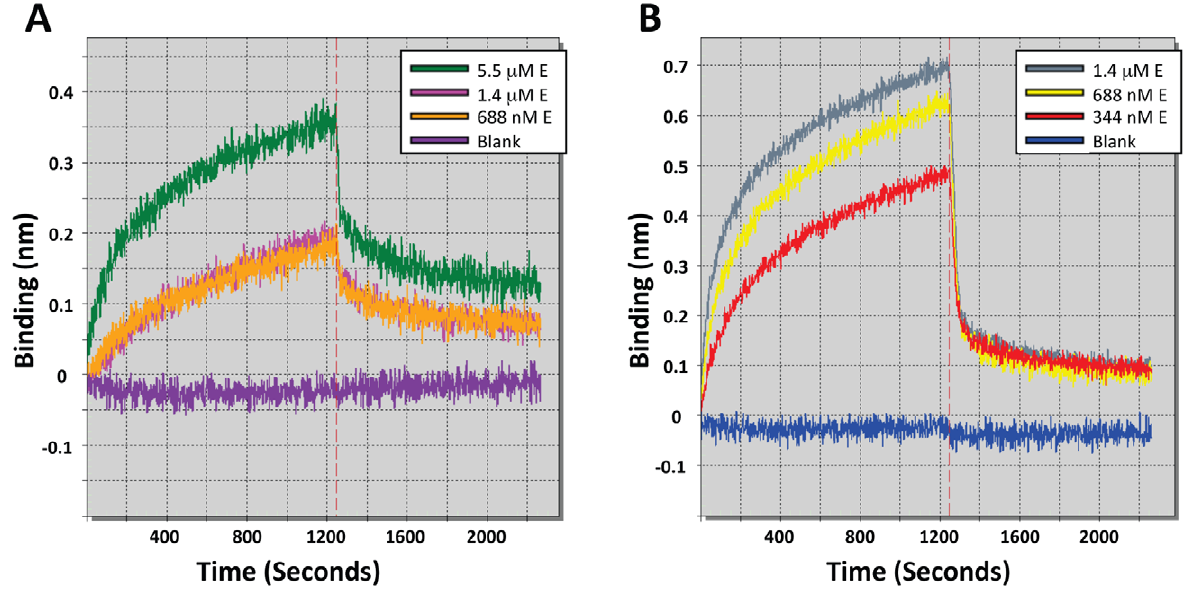
Figure 5. Peptide:E protein binding assay. Biolayer interferometry was used to assay the binding of the peptides to truncated E Protein. The association and dissociation of increasing concentrations of truncated E protein to peptides DN57opt (A) and 1OAN1 (B) are shown. A buffer blank (PBS, 0.02% Tween-20, 0.1% BSA) containing no E protein was run for each peptide. The affinity of the peptides for the truncated E protein was calculated (DN57opt